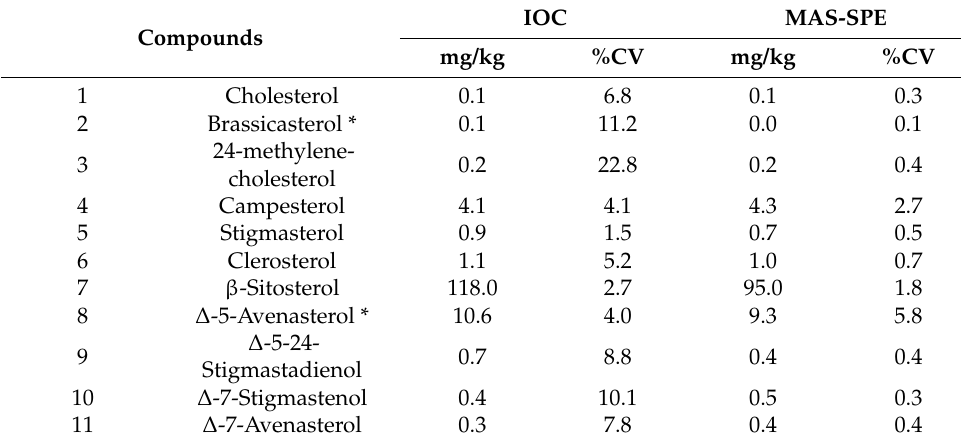
Table 1. Sterol profile in mg/kg obtained using the IOC protocol ( n = 3) and the proposed MAS-SPE method ( n = 3).